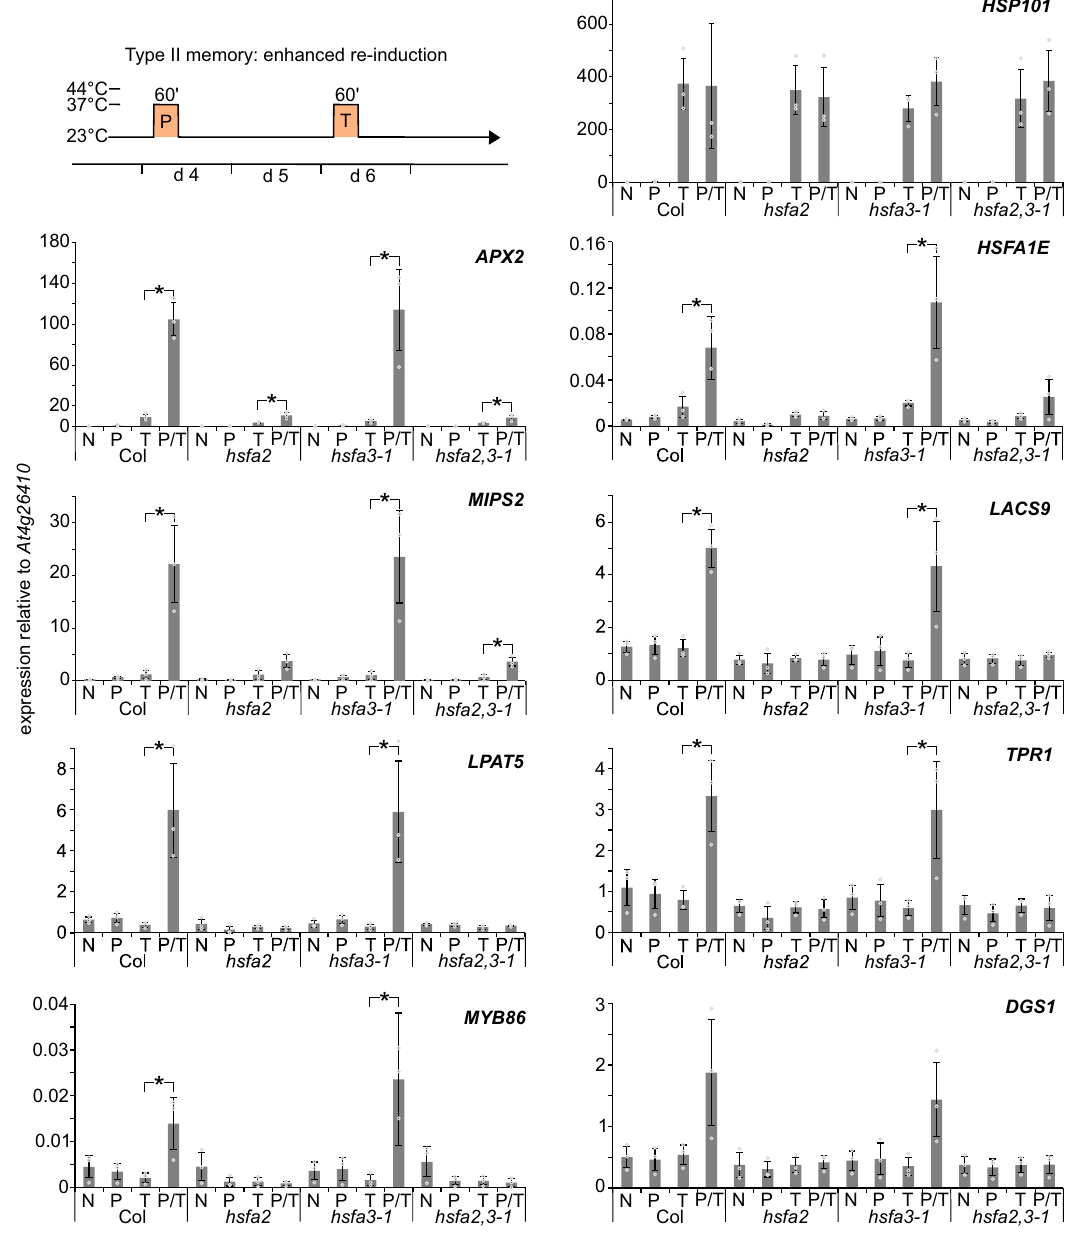
Fig. 5 Enhanced re-induction of HS memory genes depends on HSFA2 but not HSFA3 . Type II transcriptional memory (enhanced re-induction): Memory gene expression is activated by a priming treatment (P), and more highly activated by a second triggering treatment (T) 2 d later. P and T treatments consist of 37 °C for 1 h. Relative transcript levels in enhanced re-induction experiments of eight memory genes ( APX2 , HSFA1E , MIPS2 , LACS9 , LPAT5 , TPR1 , MYB86, and DGS1 ) and one non-memory gene ( HSP101 ) were measured by qRT-PCR. Plants were either not treated (N), only primed on d 4 (P), only triggered on d 6 (T), or primed on d 4 and triggered on d 6 (P + T). Regardless of their treatment, all samples were harvested on d 6 at the end of the T treatment. Data are mean ± SD of three independent experiments. Asterisks mark signi fi cant differences to Col ( p < 0.01, unpaired two-sided